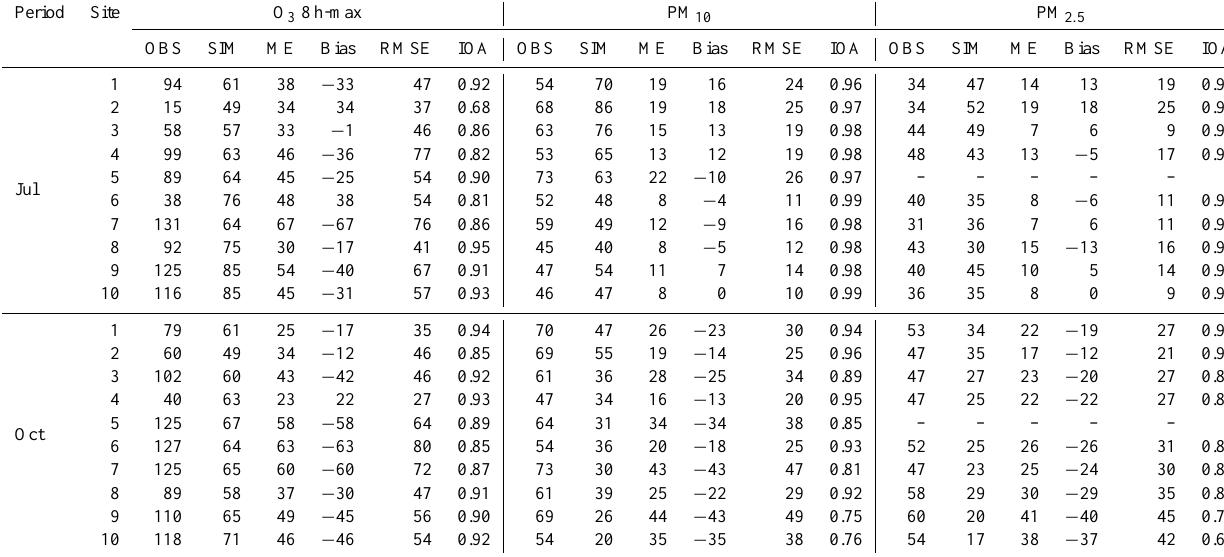
Table 2. Statistical evaluation of pollutant simulation in July and October 2010 (µgm − 3